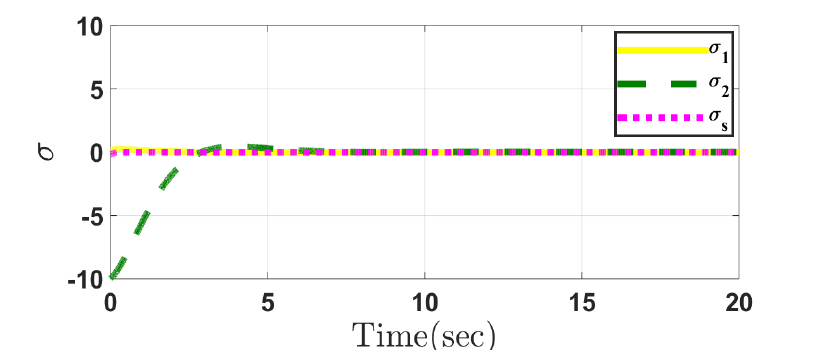
Figure 15. Sliding mode surfaces in the conventional method in Case